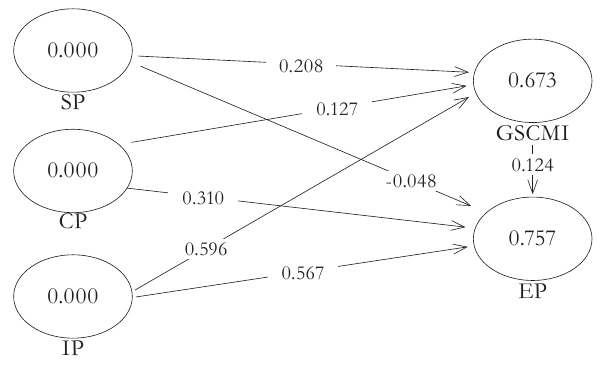
Fig. 2 – Standardized Regression Weights and Coefficients of Determination for the Proposed Research